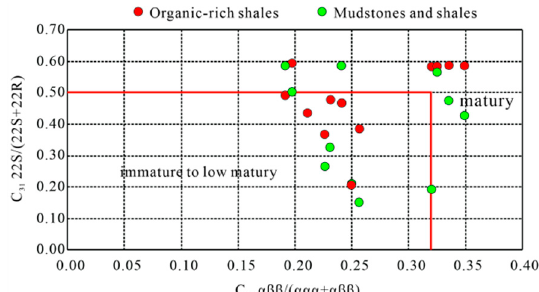
Figure 7. Cross-plot of C 29 αββ /( ααα + αββ ) sterane versus C 31 22S/(22S+22R) hopane (modified from Ref. [21]).